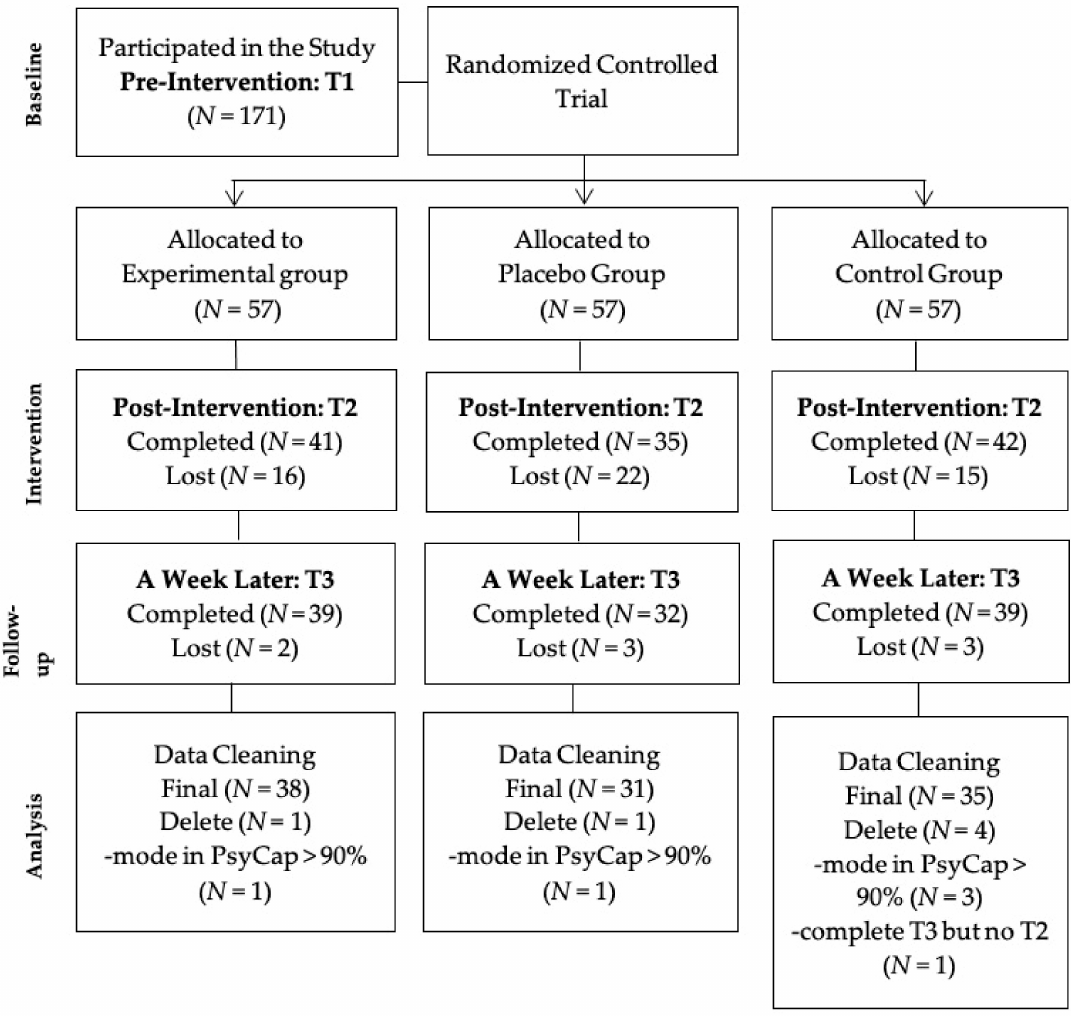
Figure 1. Participants’